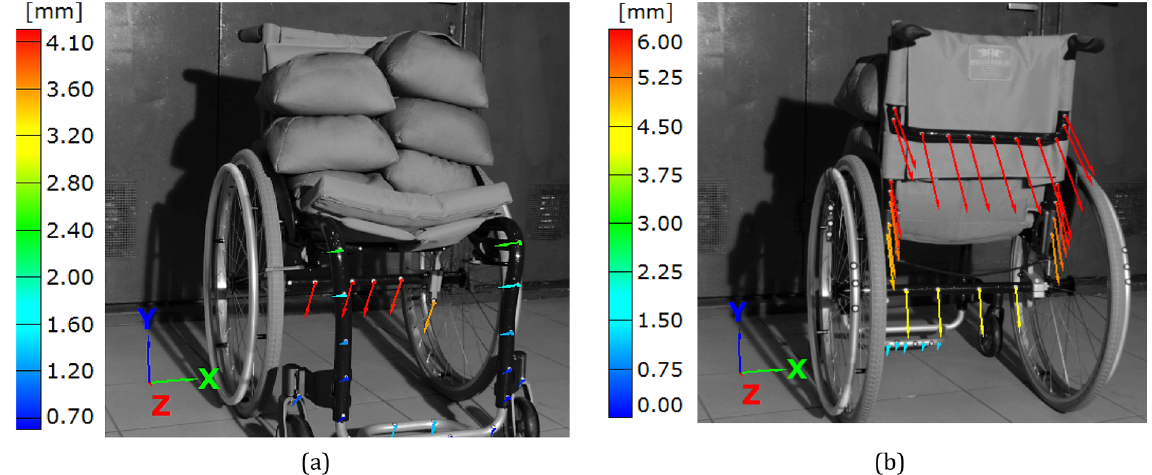
Figure 7. Distribution of the resultant vectors of deflection in the wheelchair loaded by the force of 1.5 kN in views from the front ( a ), and rear ( b ) sides,